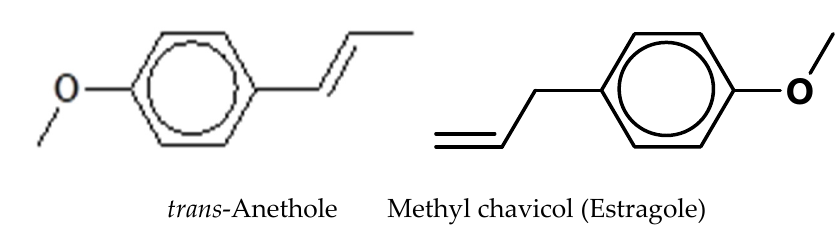
Figure 2. Structures of the main compounds identified in EOEP .